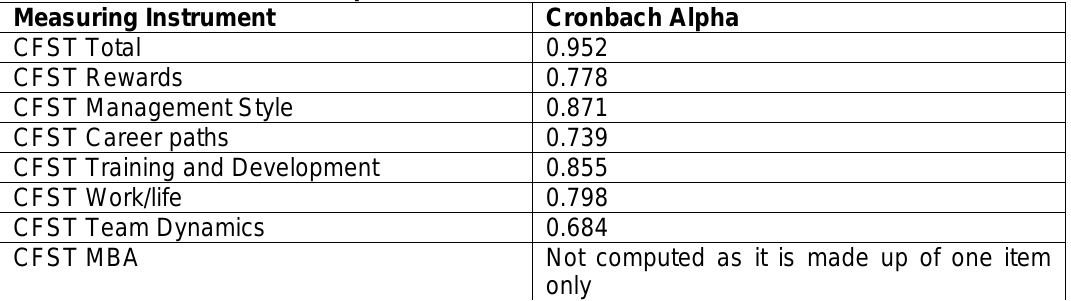
Table 1: Cronbach Alpha Results Measuring